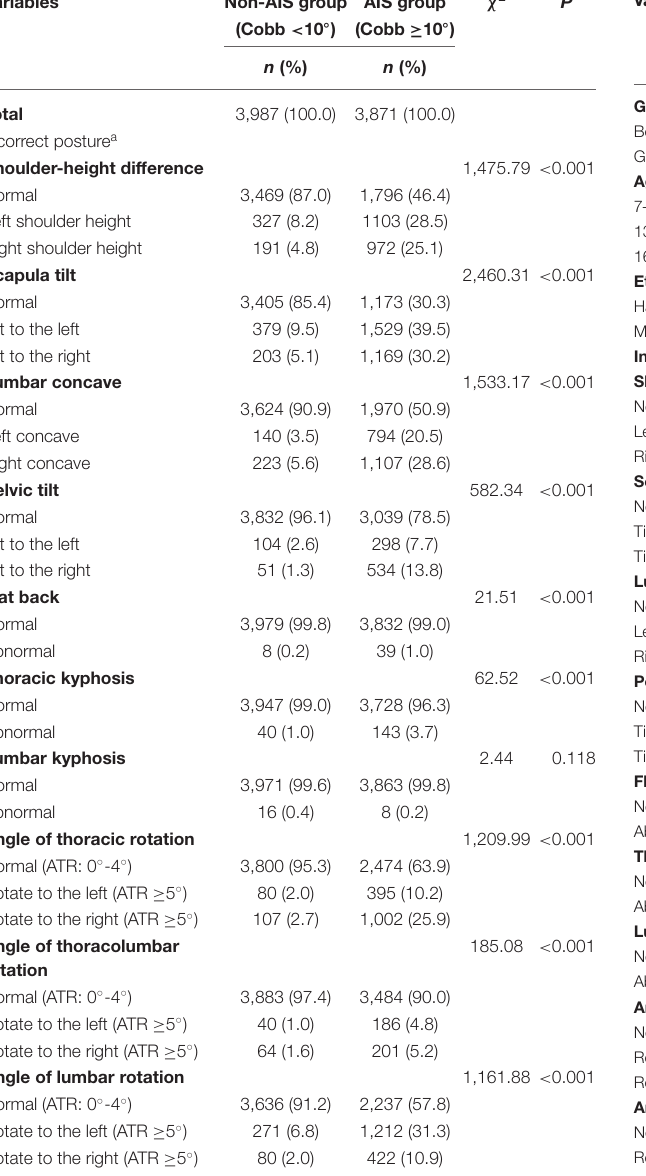
TABLE 3 | Association between incorrect posture and AIS among Chinese adolescents ( N = 7,858).